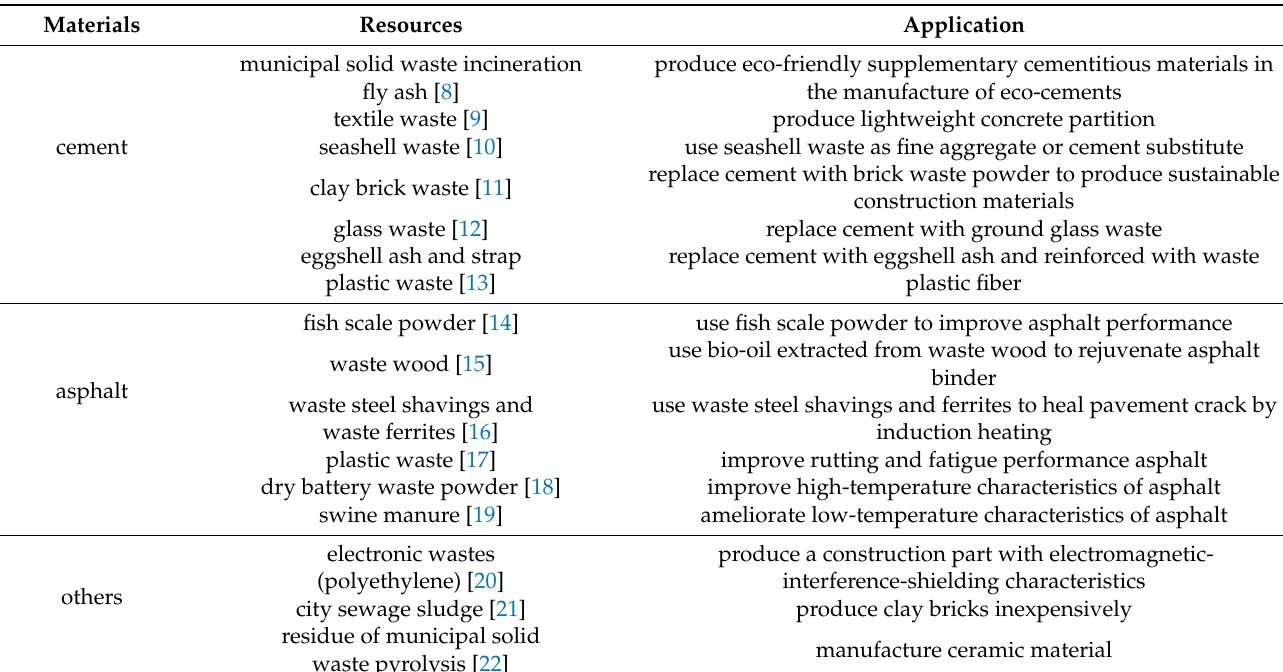
Table 1. Applications of municipal waste in construction